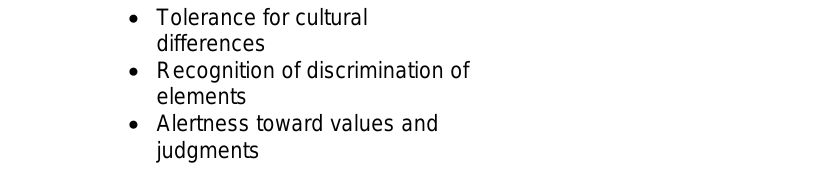
Table 2: Layers of Affect, Cognition, and